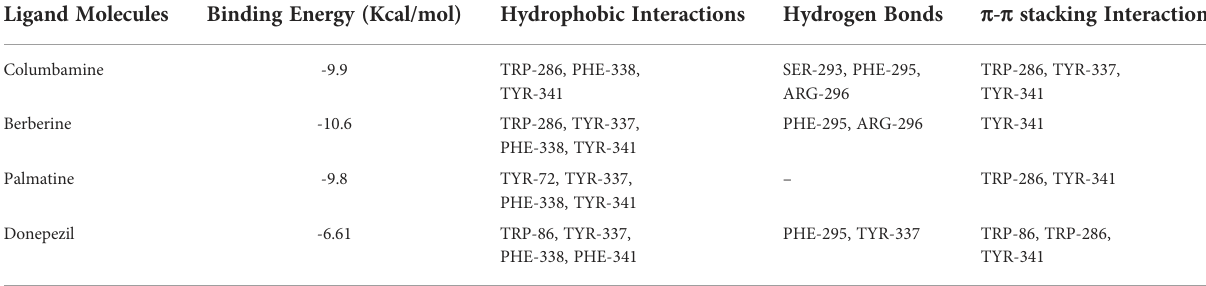
TABLE 2 Binding sites and action forces between components and AchE